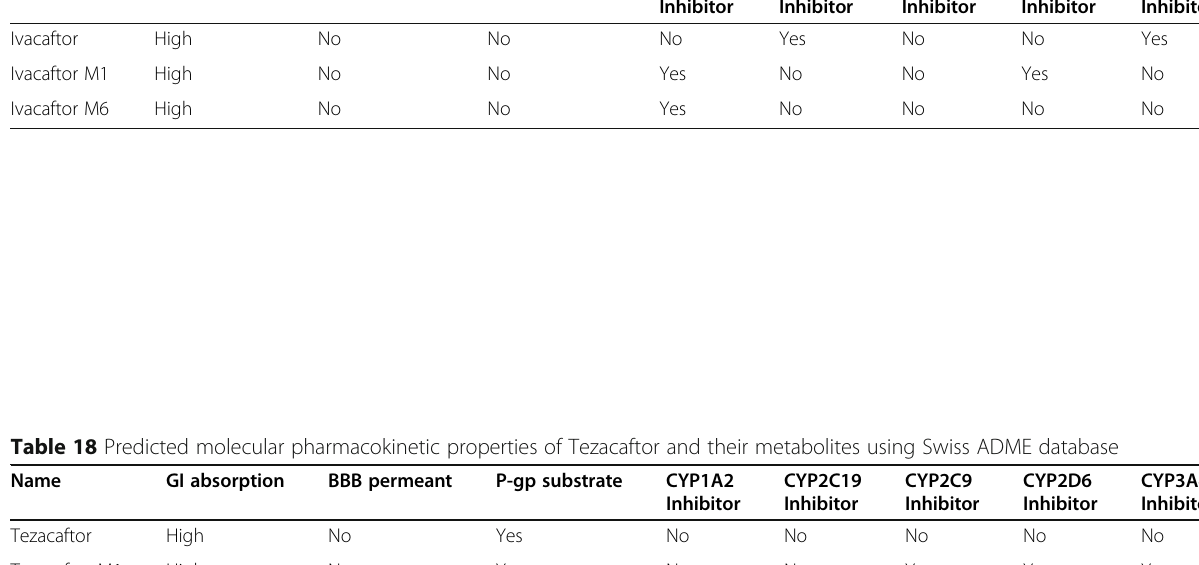
Table 17 Predicted molecular pharmacokinetic properties of Ivacaftor and its metabolites using Swiss ADME database